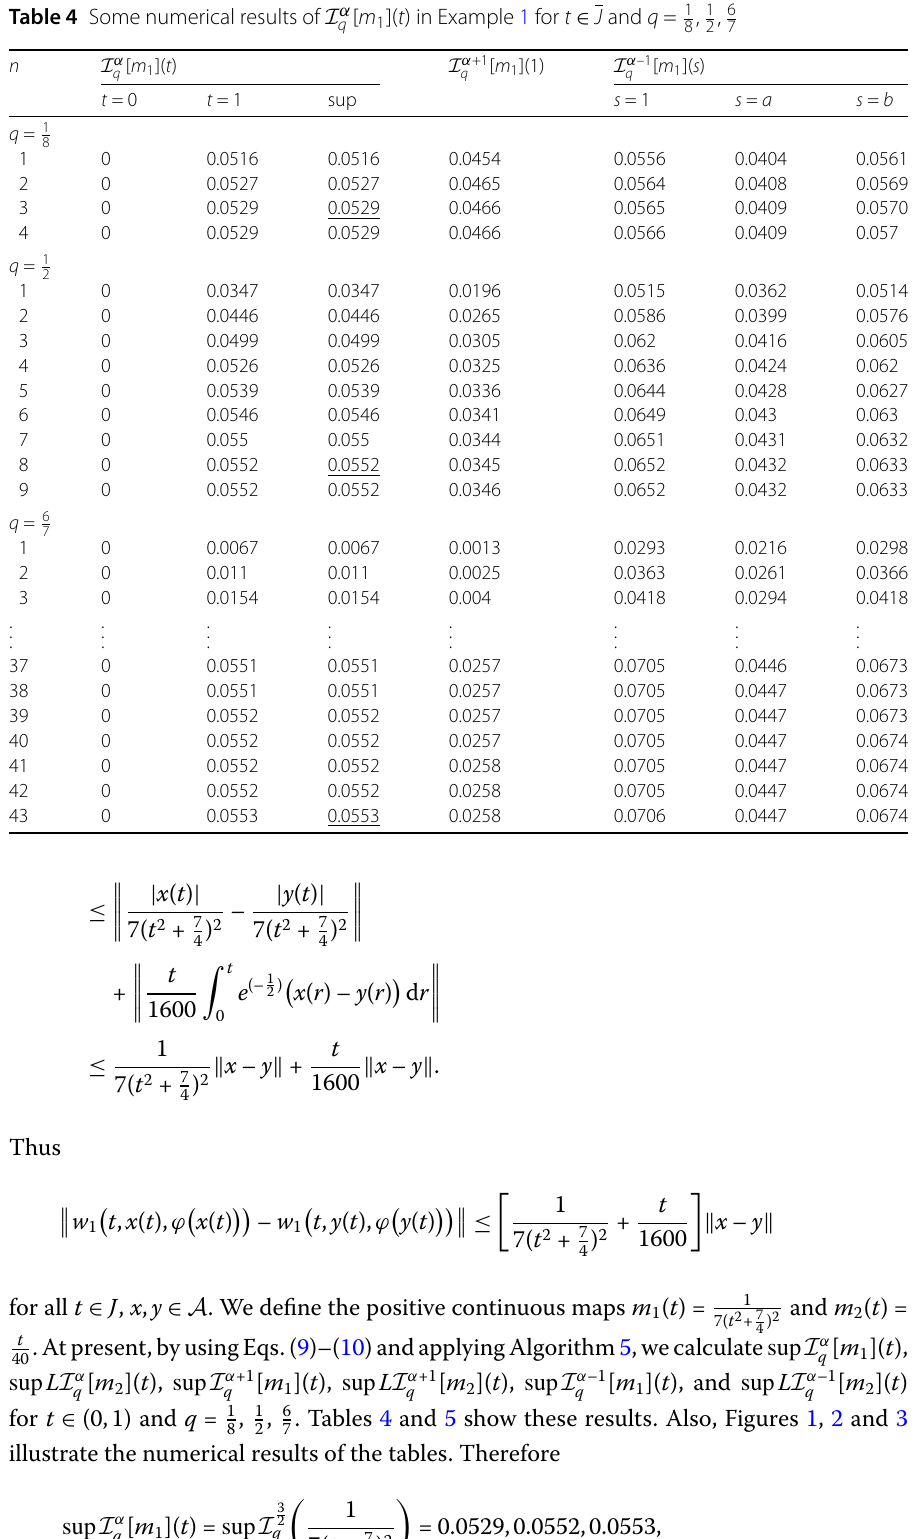
Table 4 Some numerical results of I α q [ m 1 ]( t ) in Example 1 for t ∈ J and q = 1